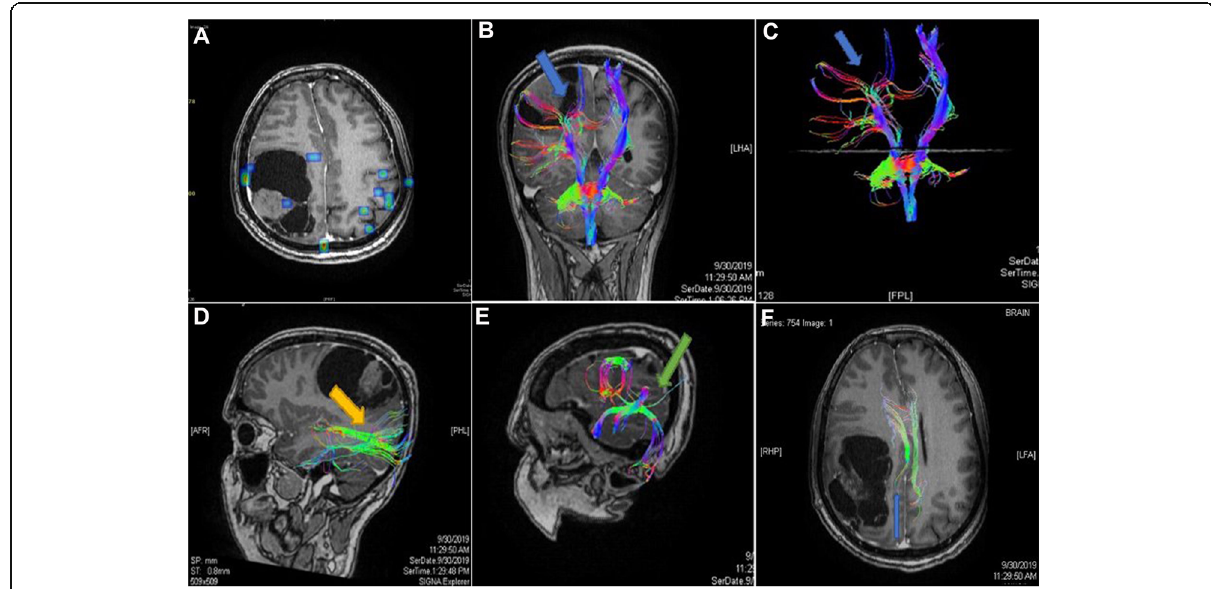
Fig. 1 Case number 1. A 53-year-old woman with a right parietal anaplastic astrocytoma, preoperative radiological examination. a Axial T1 WI with contrast revealing a right parietal lobe space occupying lesion with faint heterogeneous post-contrast enhancement. b , c Coronal T1 WI with 3D reconstruction of the corticospinal tracts (CST) showing pattern IV outward displacement, splaying and distal fibers destruction of the right CST (Blue arrows). d Sagittal T1 WI with 3D reconstruction of the right inferior longitudinal fasciculus (ILF) tract showing pattern II attenuation of ILF (orange arrow). e Sagittal T1 WI with 3D reconstruction of the right superior longitudinal fasciculus (SLF) showing pattern VI displacement and attenuation of the right SLF (green arrow). f Axial T1 WI with 3D reconstruction of the cingulum tracts showing pattern III attenuation of the right tract (blue arrow)